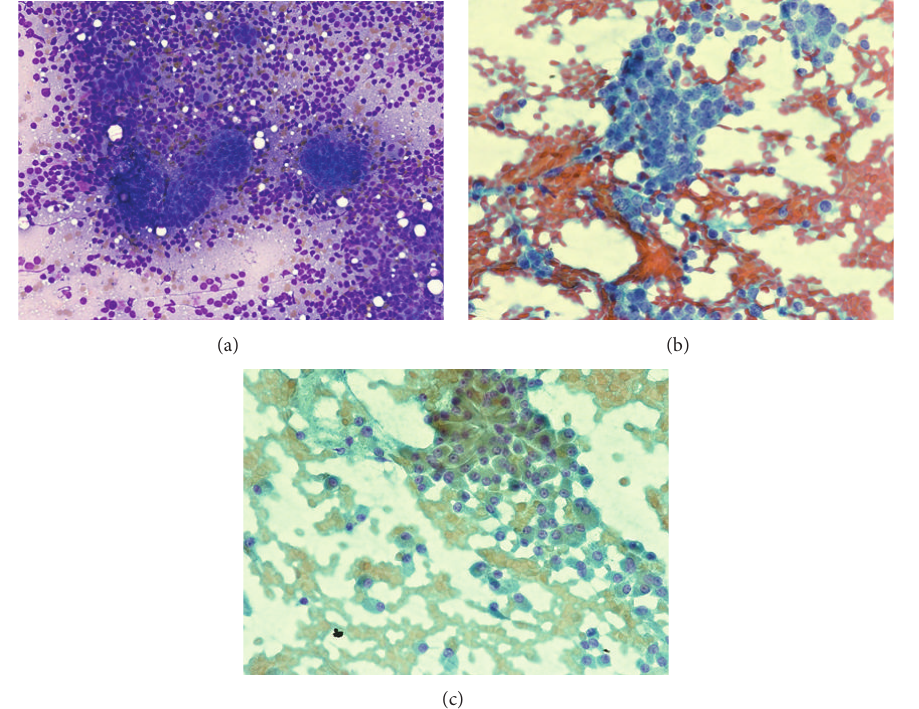
Figure 3: (a) Lymph node FNA showing metastatic follicular carcinoma. (b) Lymph node FNA showing metastatic follicular carcinoma. (c) Lymph node FNA showing metastatic follicular